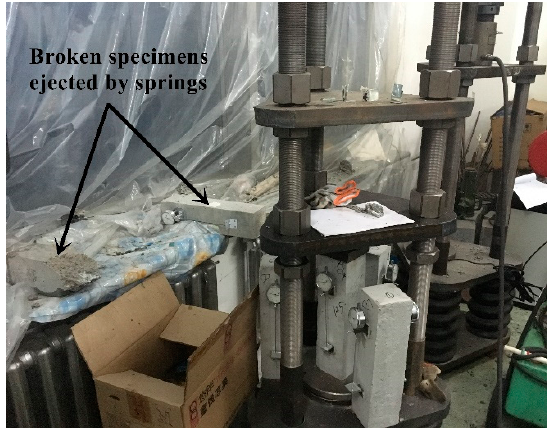
Figure 5. Broken specimens under stress–strength ratio of 0.75.